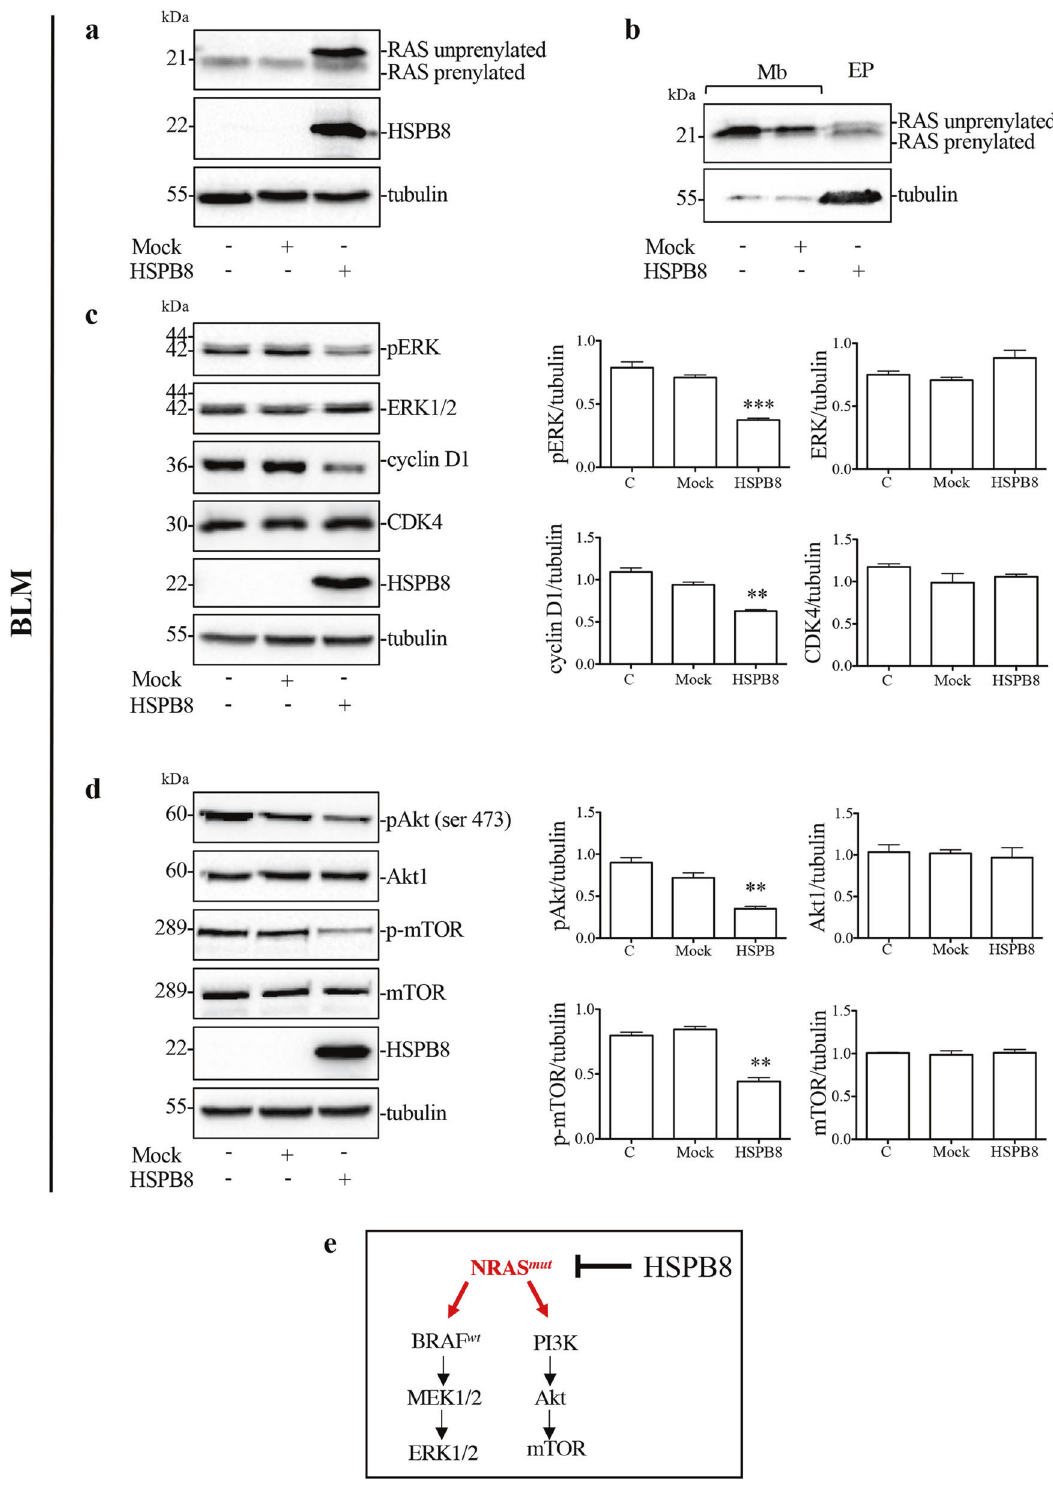
Fig. 3 Effect of HSPB8 overexpression on NRAS pathway in BLM cells. a WB analysis of RAS protein level in BLM cells overexpressing HSPB8 (48 h). Tubulin was used as loading control. b WB analysis of RAS protein levels in plasma membranes (Mb) of BLM cells expressing HSPB8 (48 h) compared with total protein extracts (EP). c Effect of HSPB8 overexpression (48 h) on MAPK pathway. Tubulin was used as loading control. Three independent biological samples for each condition were analyzed ( N = 3), bar graph represents the mean optical density ± SD. Statistical analysis was performed using One-way ANOVA followed by Bonferroni post-hoc test (** p < 0.01 vs. C and mock *** p < 0.001 vs. C and mock). d Effect of HSPB8 overexpression (48 h) on Akt/mTOR pathway. Tubulin was used as loading control. Three independent biological samples for each condition were analyzed ( N = 3), bar graph represents the mean optical density ± SD. Statistical analysis was performed using One-way ANOVA followed by Bonferroni post-hoc test (** p < 0.01 vs. C and mock). e Schematic representation of HSPB8 effect on NRAS mut activity.